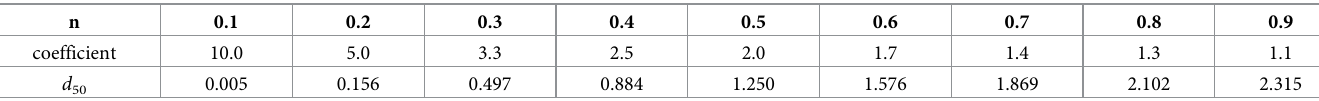
Table 3. Calculation table of d 50